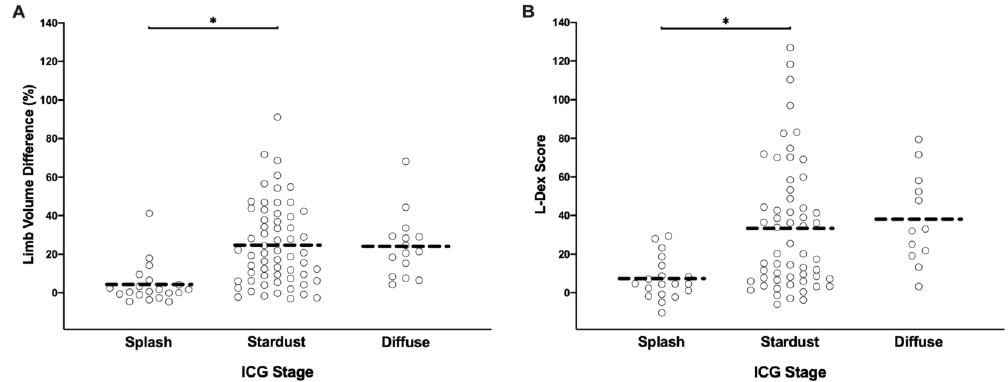
Figure 7. ( A ) Scatter plot of limb volume difference (%) distribution by ICG stages. ( B ) Scatter plot of L-Dex score distribution by ICG